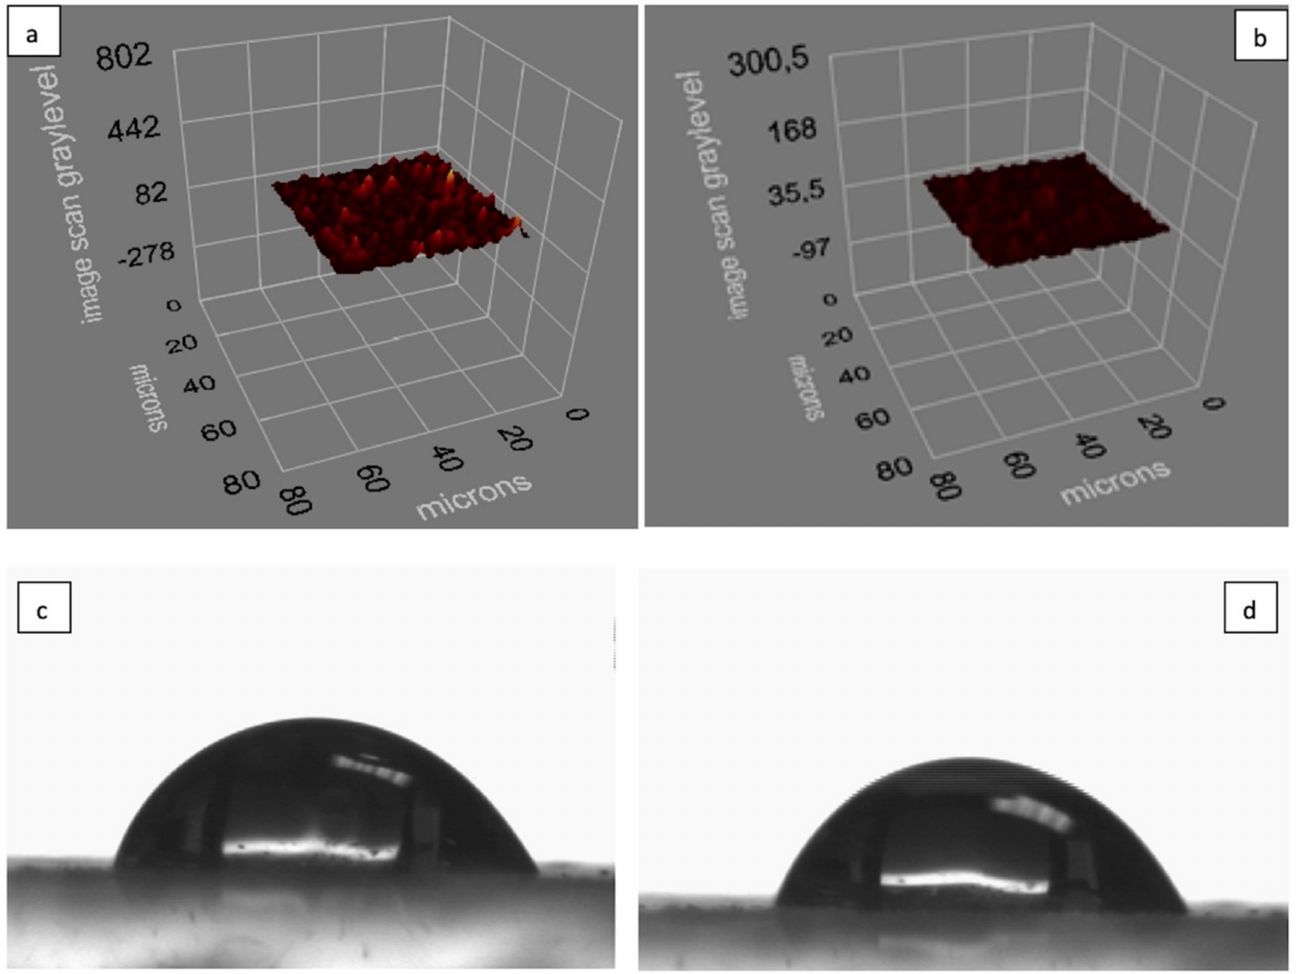
Figure 3. Ellipsometry analysis of S. aureus- imprinted SPR sensor chips ( a ) and non-imprinted SPR sensor chips ( b ). Contact angle measurements of S. aureus -imprinted SPR sensor chips ( c ) and non-imprinted SPR sensor chips ( d